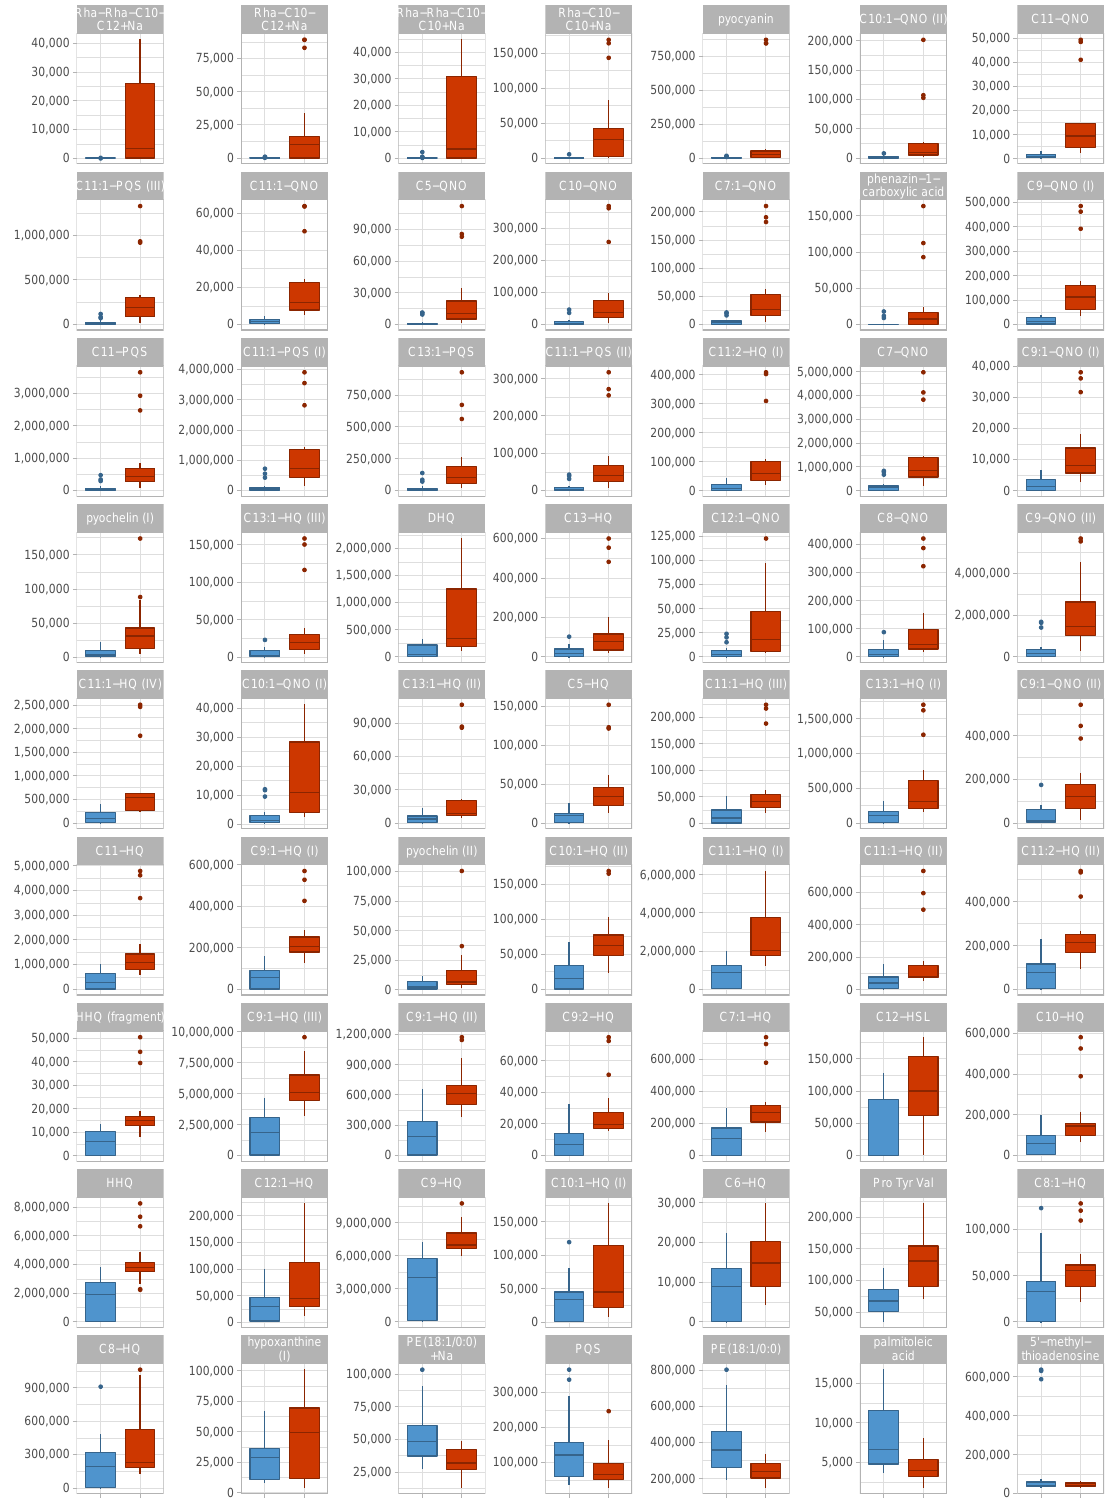
Figure 3. Box plots of identified metabolites in the discovery data set. Data distribution for all identified metabolites with an absolute fold change of ≥ 1.5 are shown as box plots. For each metabolite, one boxplot shows the abundances in each group. Red—virulent cluster A strains, blue—avirulent cluster B